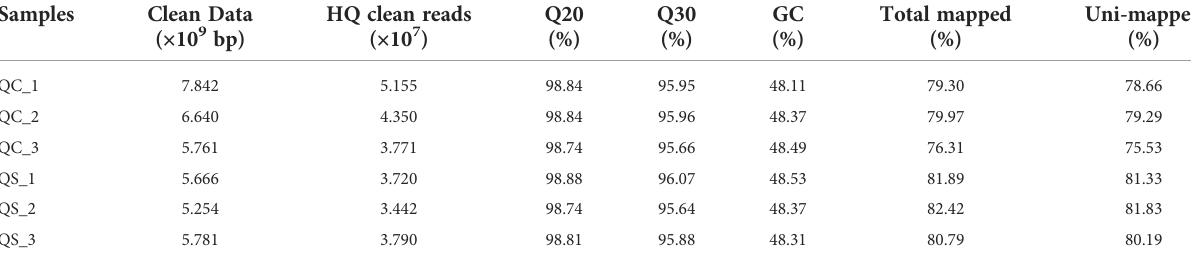
TABLE 1 The reads information after fi ltering in RNA-seq. Samples